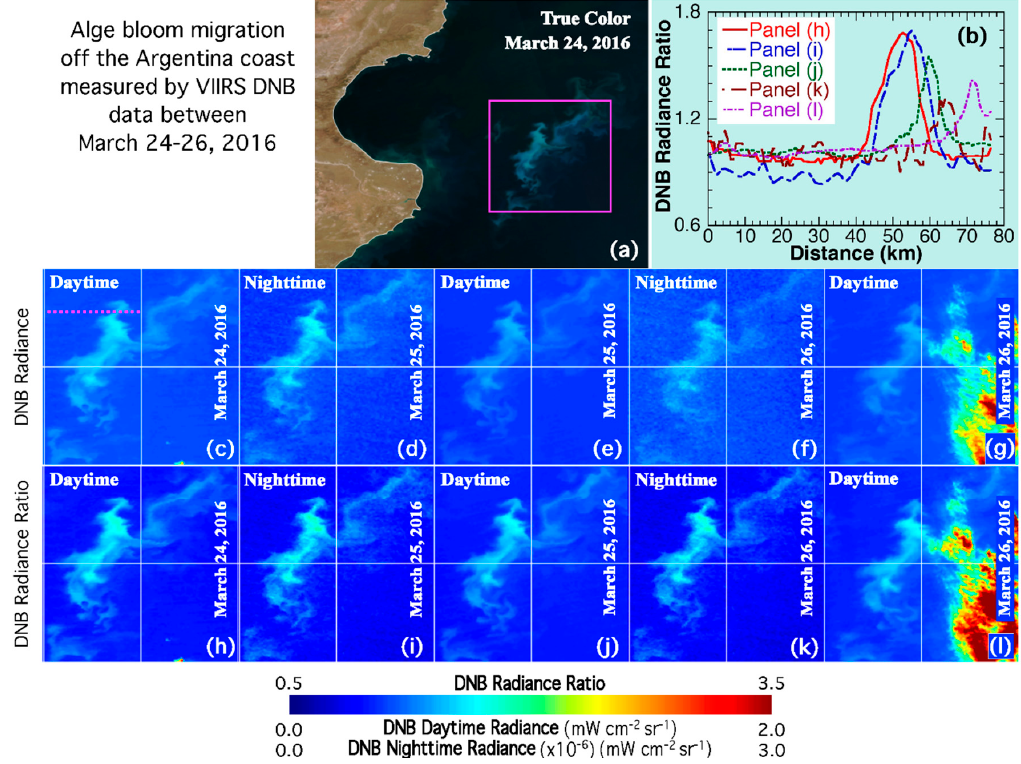
Figure 2. VIIRS-observed algal bloom off the Argentinian coast in the South Atlantic for ( a ) RSB daytime true color image at 17:19 UTC on 24 March 2016, with the marked box showing a region for further analysis using VIIRS DNB observations, ( b ) DNB radiance ratio R along the transect line indicated in Figure 2c with different daytime and nighttime observations, ( c – g ) DNB TOA radiance at 17:19 UTC on 24 March 2016, 04:48 UTC on 25 March 2016, 18:44 UTC on 25 March 2016, 04:30 UTC on 26 March 2016, 18:27 UTC on 26 March 2016, respectively, and ( h – l ) DNB TOA radiance ratio at 17:19 UTC on 24 March 2016, 04:48 UTC on 25 March 2016, 18:44 UTC on 25 March 2016, 04:30 UTC on 26 March 2016, and 18:27 UTC on 26 March 2016, respectively.